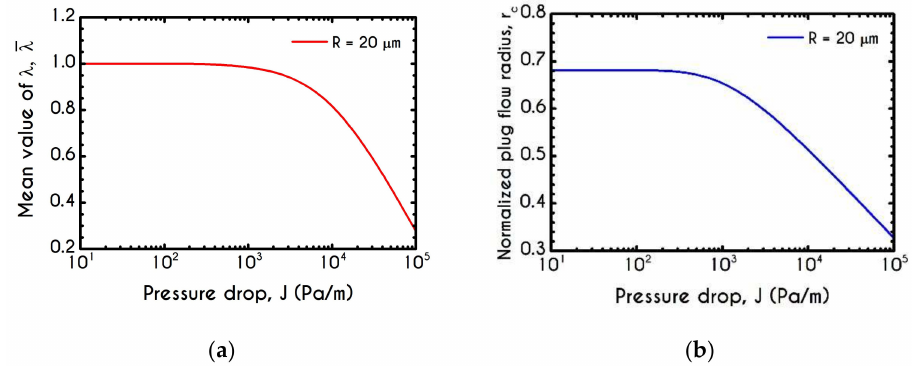
Figure 22. ( a ) Mean structure parameter λ , ( b ) Normalized plug-flow radius r c as a function of the pressure gradient J for R = 20 µ m and H c =